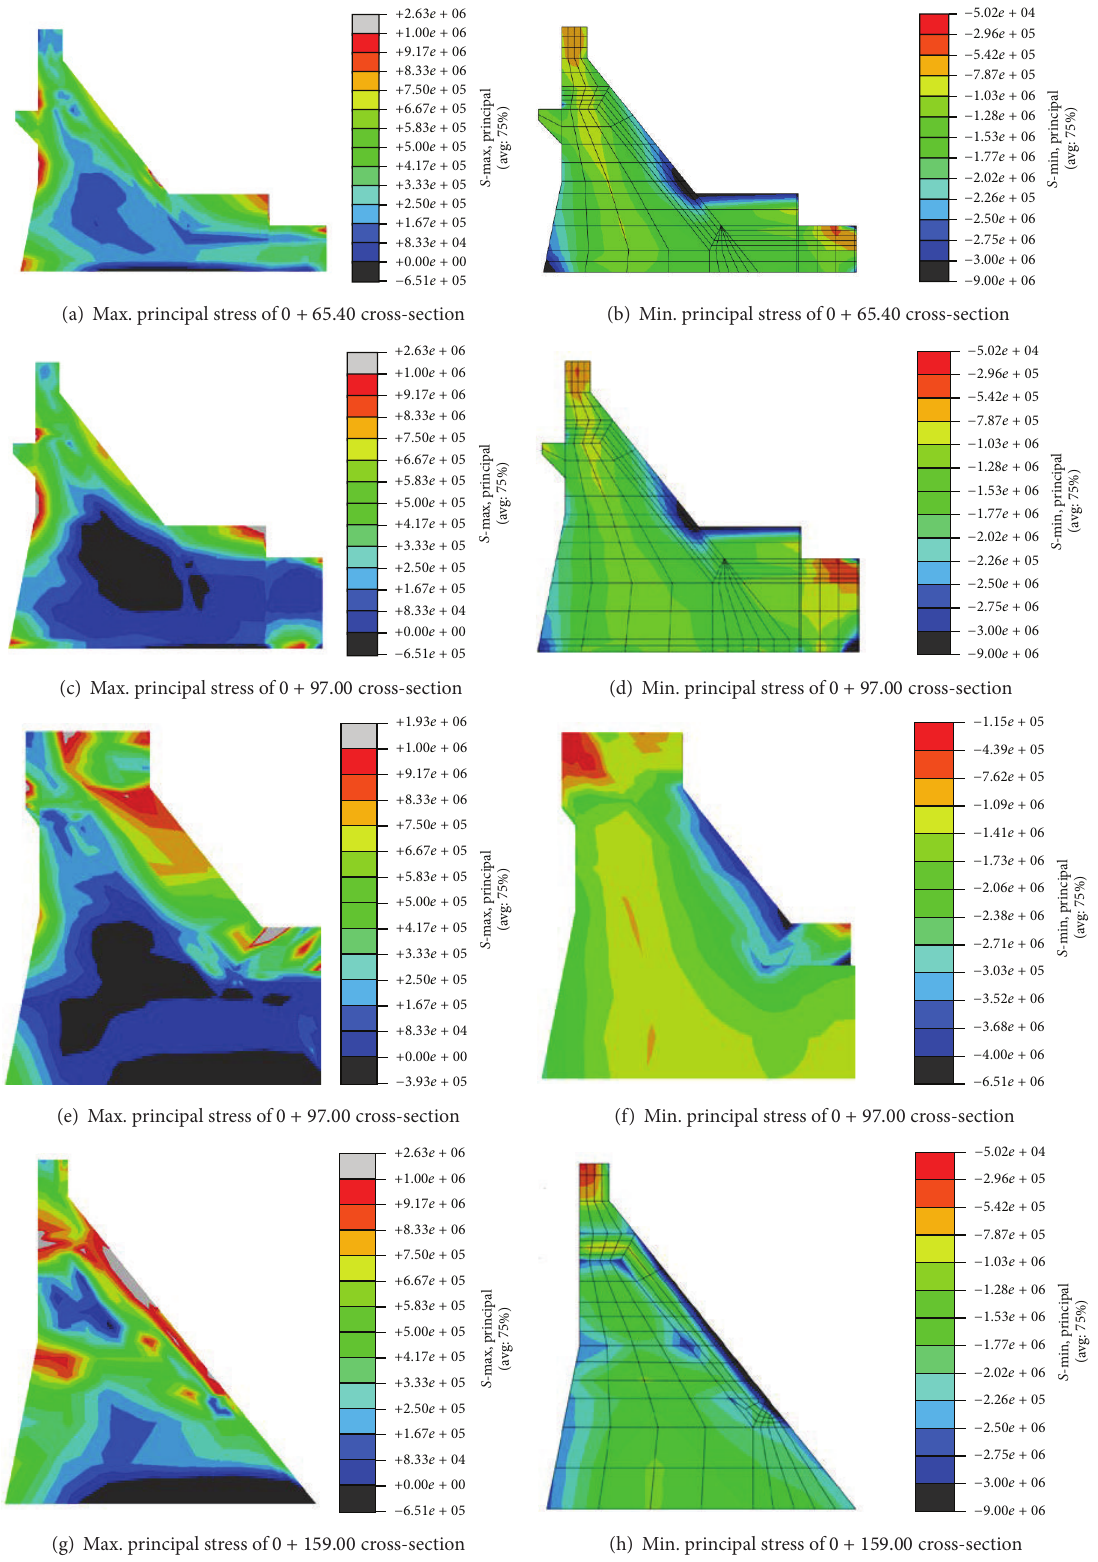
Figure 7: Principal stress of typical section under analysis Case 4 (unit: